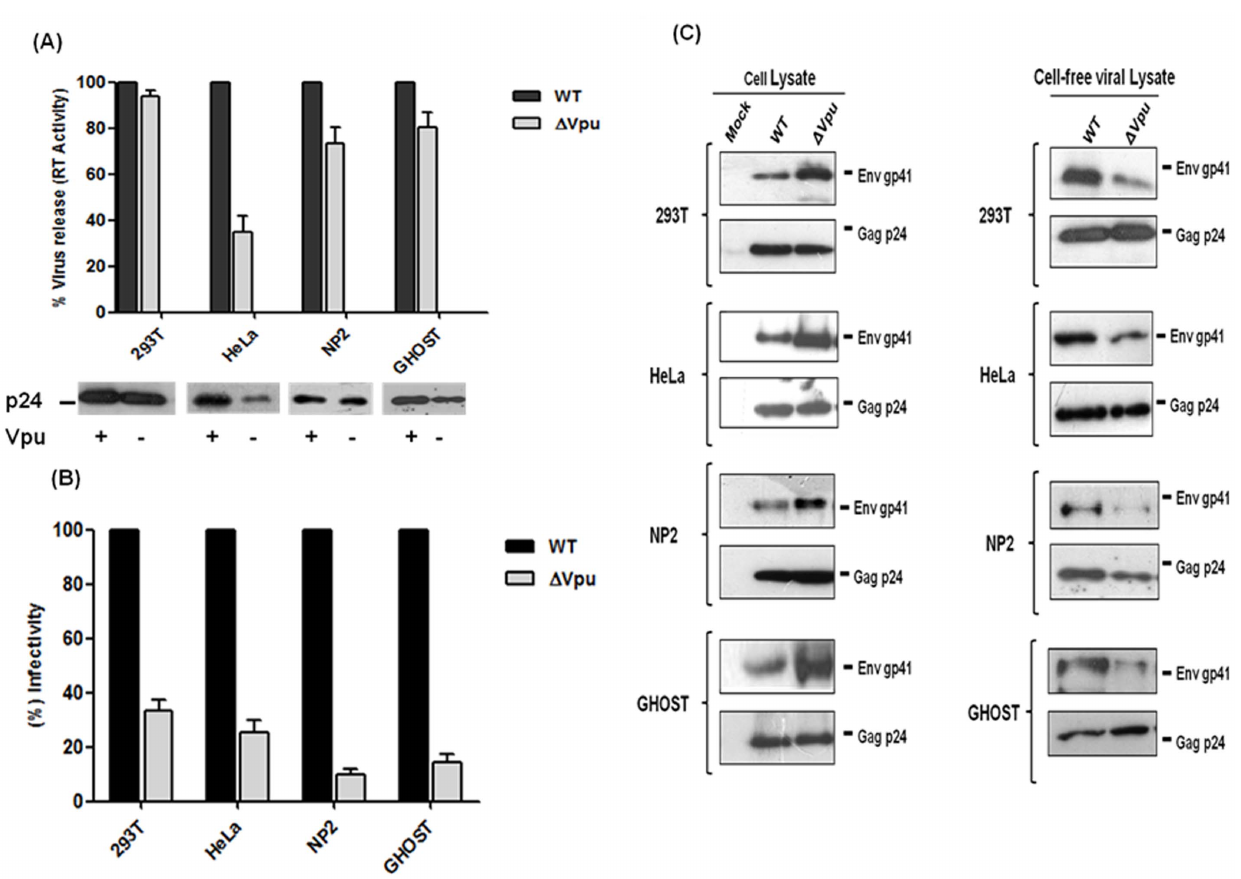
Figure 2. Differential effects of Vpu start codon mutation on release and infectivity of viruses from different cell types. Cell lines (293T, HeLa, NP2 and GHOST) were transfected with equal amount of wild-type pNL-AD8 (WT) plasmid and its Vpu defective variant ( D Vpu). At 48 h post-transfection, supernatants were harvested, clarified by centrifugation and filtered through 0.4 m m syringe filters. At the same time cell lysates were also prepared and cleared of cell debris and nuclei by centrifugation. (A) The amount of virus release in the supernatant was determined by measuring viral reverse transcriptase (RT) activity through RT-ELISA. Quantification of RT activity was done in duplicates, the average percent release and standard error was calculated considering WT release as 100%. Virus release was also evaluated by assessing viral Gag p24 protein in viral supernatants by 10% SDS-PAGE followed by Western blotting with HIV-1 Gag anti-p24 antibody (183-H12-5C). (B) Infectivity of D Vpu viruses with respect to WT was determined in TZM-bl indicator cells. Clarified viral supernatants from transfected cells were serially diluted and added to the TZM- bl cells. At 48 h post-infection, infectivity was determined by measuring Luciferase activity as RLU (Relative Luminescence unit) using Luminometer. The average of RLU and standard error was calculated. Figure represents percent change in infectivity with respect to WT which was considered as 100%. (C) Western blots shown represent cell-associated and cell-free viral proteins. For blot of viral proteins, viral supernatants were concentrated by ultracentrifugation using 20% sucrose cushion and run in 10% SDS-PAGE. Before loading, viral lysates were normalized by RT value and equal RT values were subjected to SDS-PAGE. Viral proteins of both cell-associated and cell-free lysates were analyzed by using anti-p24 (183-H12-5C) and anti- gp41 (Chessie 8) antibodies. The release and infectivity experiments were performed in duplicates and the results shown are representative of three independent experiments.